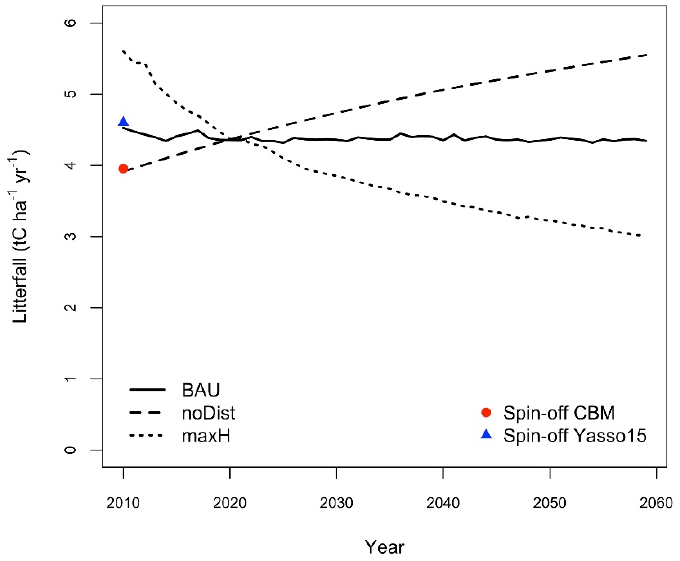
Figure 6. Trend of the litterfall averaged for all forest types, over the simulated period associated to the three scenarios: business as usual harvest scenario (BAU), no disturbances scenario (noDist), and maximum harvest scenario (maxH).